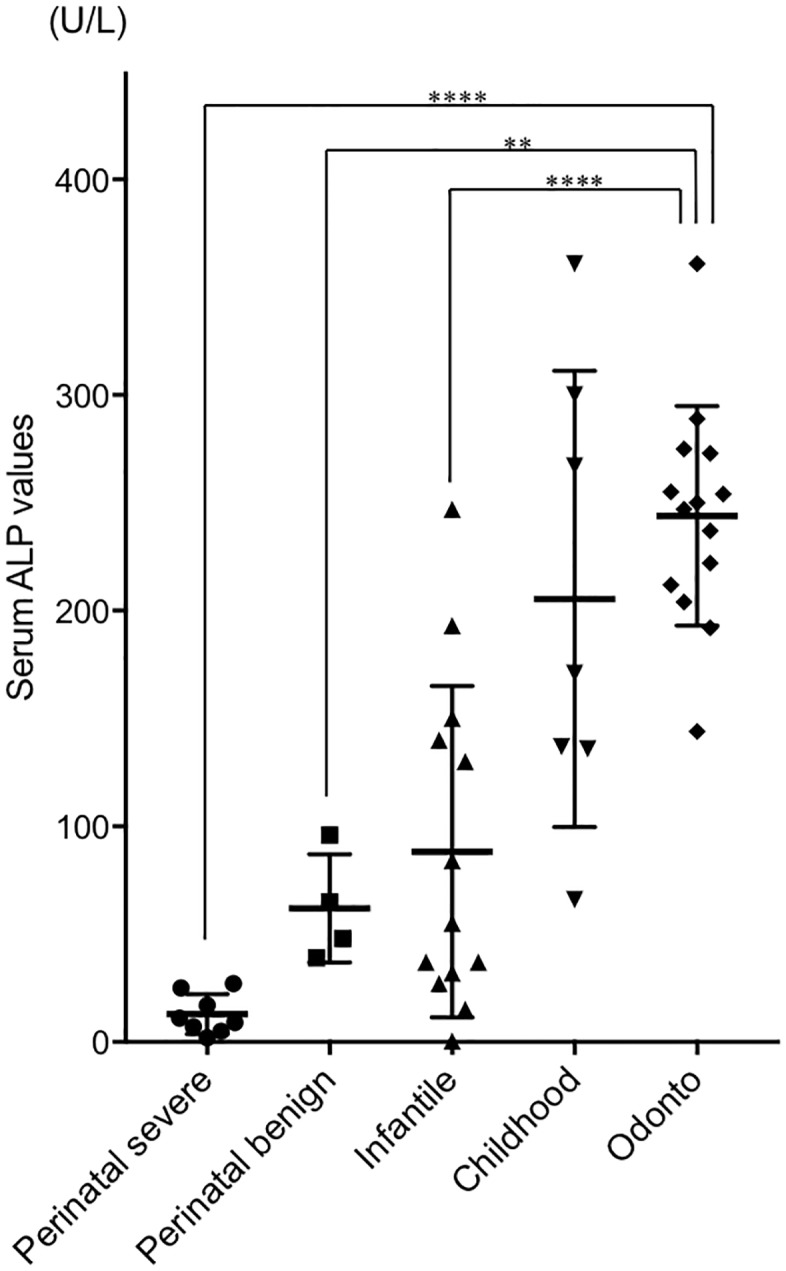
Distribution of serum ALP values of each clinical type.Significant differences were determined using ANOVA with Bonferroni correction. **P<0.05 and ****P<0.0001 versus odonto type.